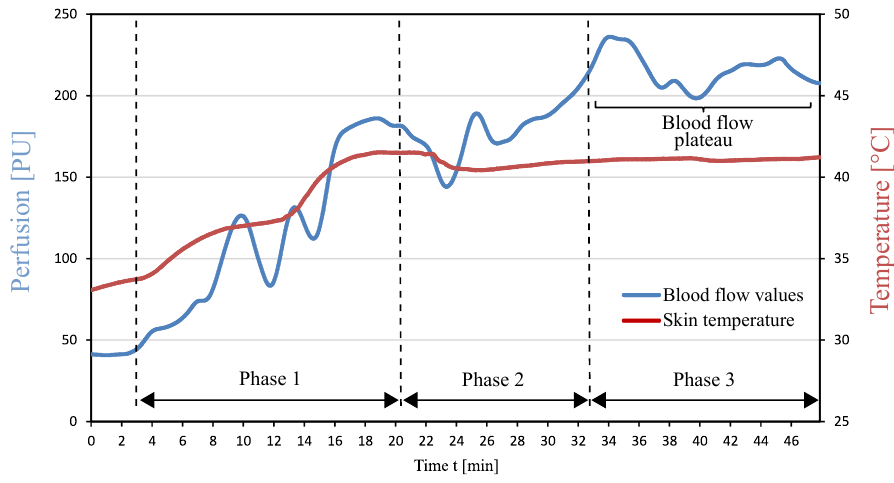
Figure 3. Blood flow during local warming of the forearm.